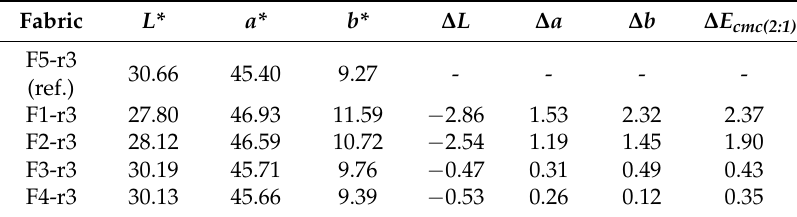
Table 2. Color specifications of fabrics rinsed with freshwater or treated effluents.